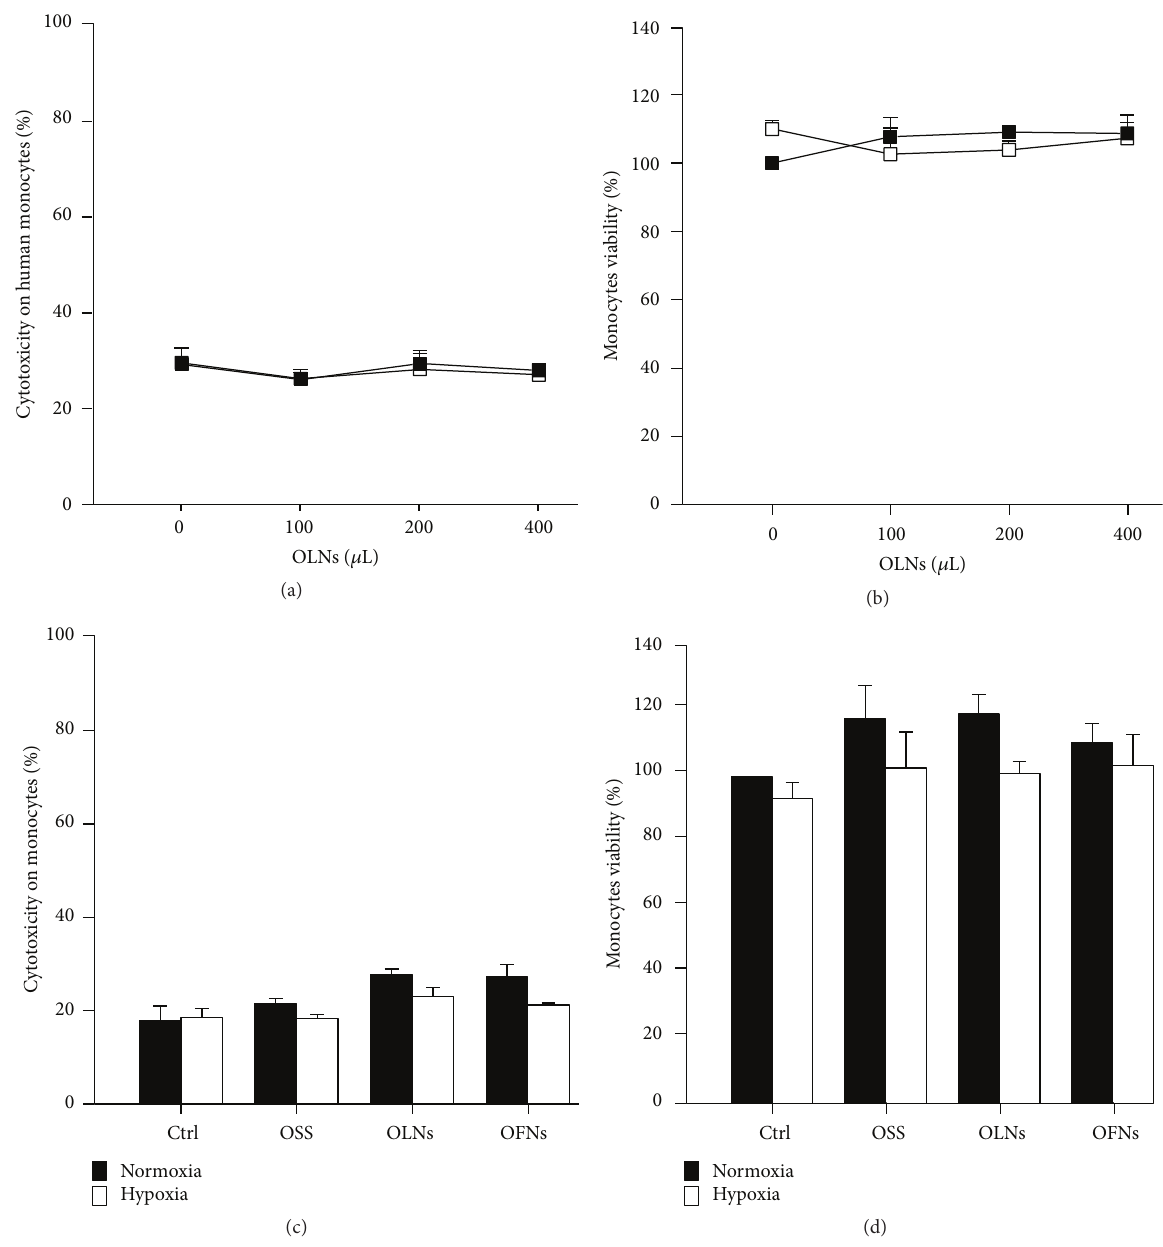
Figure 1: Hypoxia and OLN effects on human monocyte viability. Human adherent monocytes (10 6 cells/2 mL Panserin 601 medium) were left untreated or treated with increasing doses (100–400 𝜇 L) of OLNs or with 200 𝜇 L OFNs or OSS for 24 h in normoxia (20% O 2 , black columns/squared-lines) or hypoxia (1% O 2 , white columns/squared-lines). After collection of cell supernatants and lysates, cytotoxicity percentage was measured through LDH assay (panels (a) and (c)), whereas cell viability percentage was measured through MTT assay (panels (b) and (d)). Results are shown as means + SEM from three independent experiments. Data were also evaluated for significance by